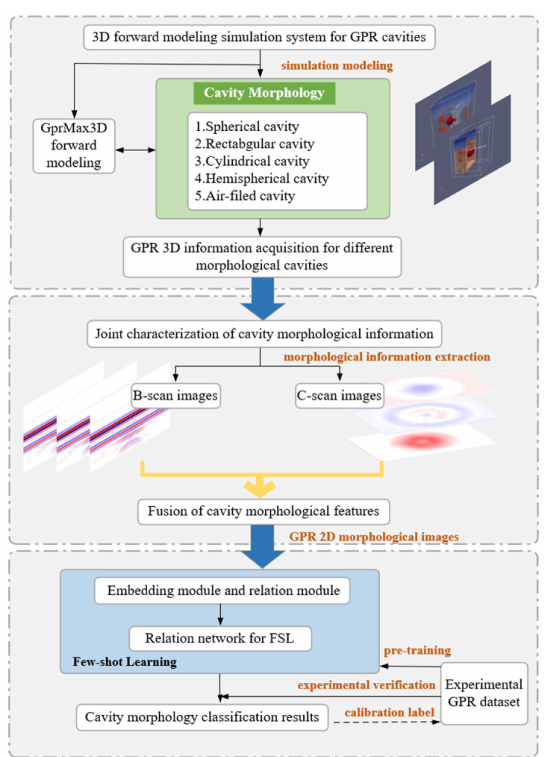
Figure 1. GPR cavity morphology recognition